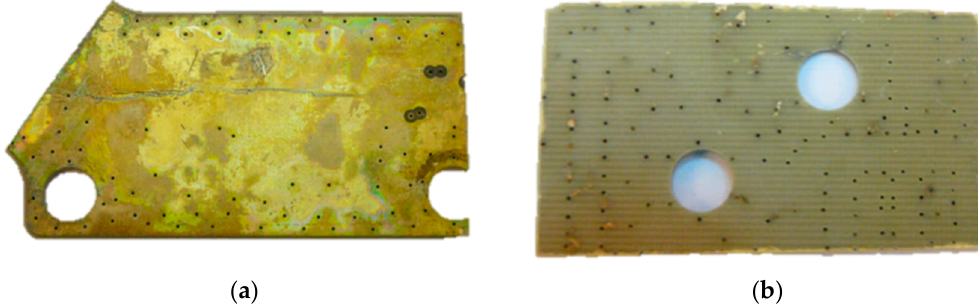
Figure 4. The WPCB pieces after leaching experiment L3 in 8% aqua regia at temperatures ( a ) 40 and ( b ) 80 °C.